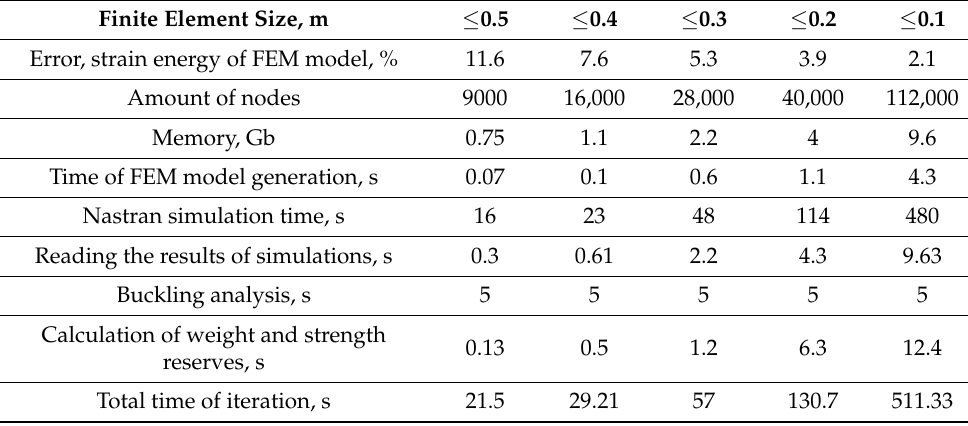
Table 6. Computational capabilities of strength analysis of a regional